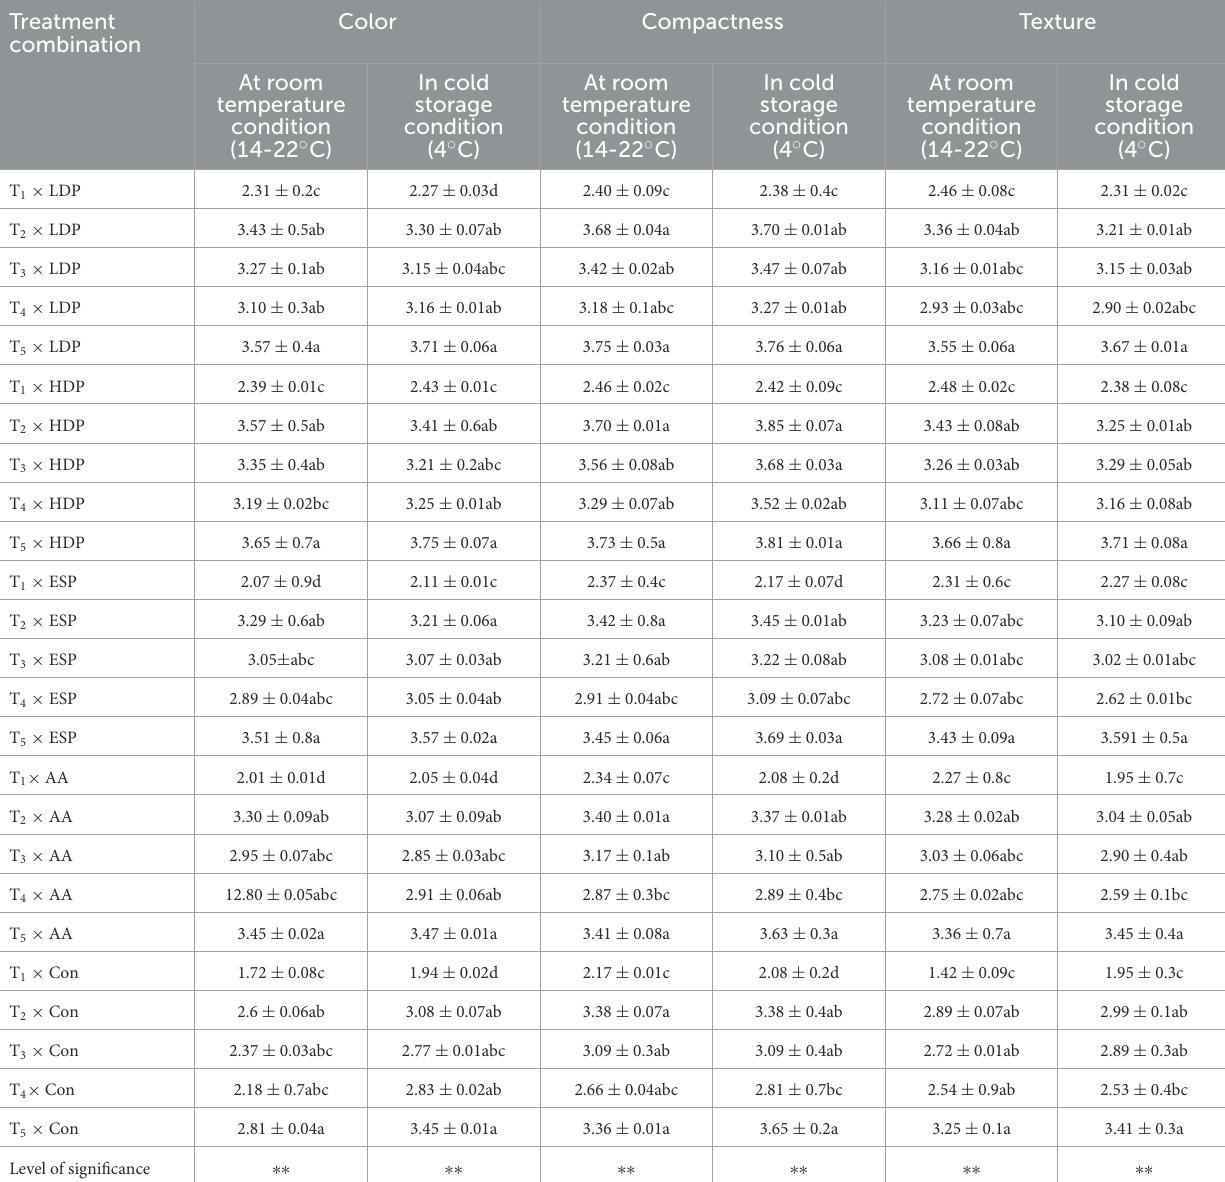
TABLE 5 Effects of pre-harvest foliar application of mineral nutrient sources and post-harvest packaging and chemical treatments on quality attributes in storage broccoli heads under different storage temperatures at the maximum shelf-life stage. Treatment